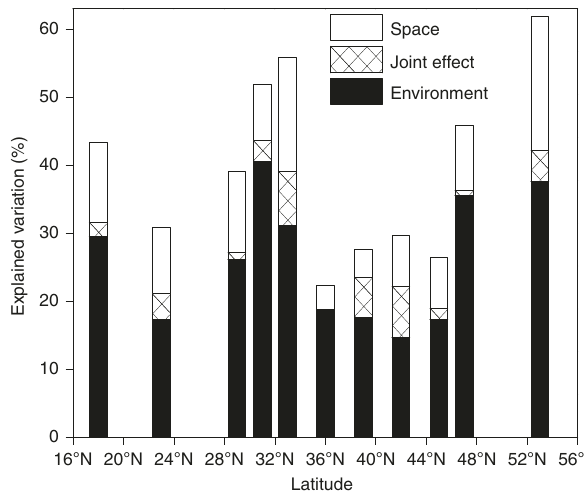
Fig. 6 Percent of β deviations explained by environmental and spatial variables. Environmental and spatial variables are listed in Supplementary Table 7. The source data are provided as a Source data fi le.